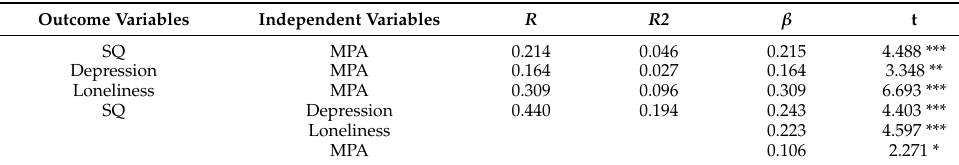
Table 2. The regression analysis of variable